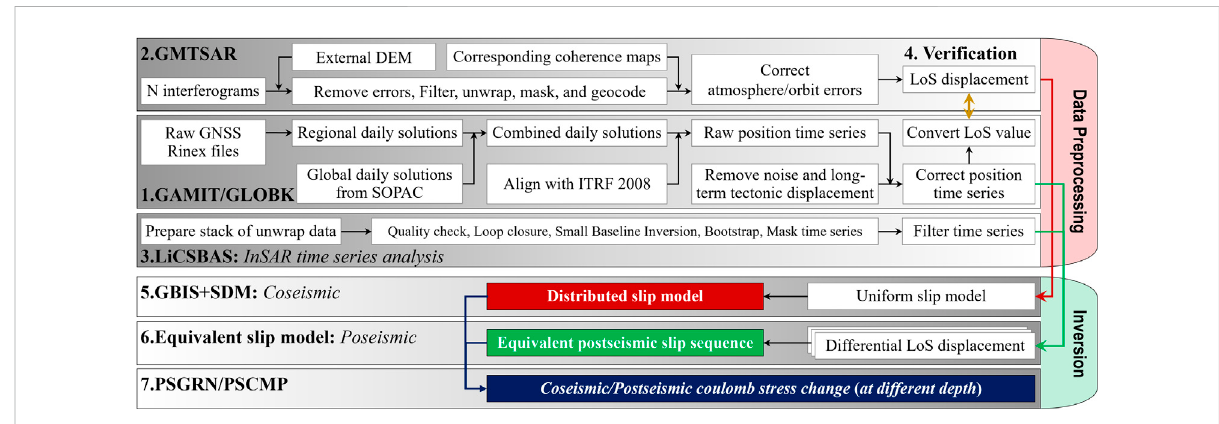
FIGURE 3 Inversion processing fl owchart of coseismic and postseismic slip models with GNSS and InSAR datasets.